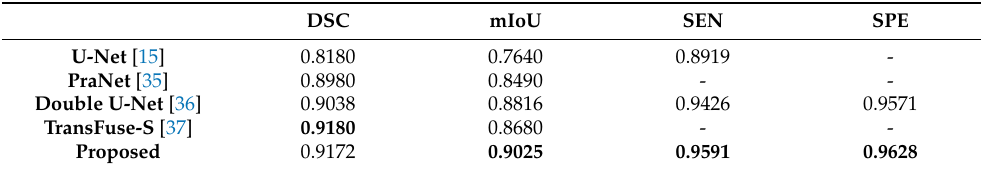
Figure 9. ISIC 2017 Segmentation output sample: the third row shows the resulting graph of U-Net. On the Kvasir-SEG dataset, we compared it with the currently popular Double U-Net, Pra-Net, and U-Net. The results show that our method is highly competitive. DSC is 1.34%, 1.92%, and 9.92% higher than Double U-Net, Pra-Net, and U-Net, respectively; it only has a 0.12% difference from the TransFuse-S architecture. However, we show the large advantage with a high mIoU of 0.9025. SEN is 1.65% and 6.72% higher than U-Net and Double U-Net, respectively (as shown in Table 5). An experimental comparison between U-Net and our method is given in Figure 10, and our proposal shows a more robust output in tiny tissue regions. Table 5. Comparison of results of different network architectures on the Kvasir-SEG dataset.